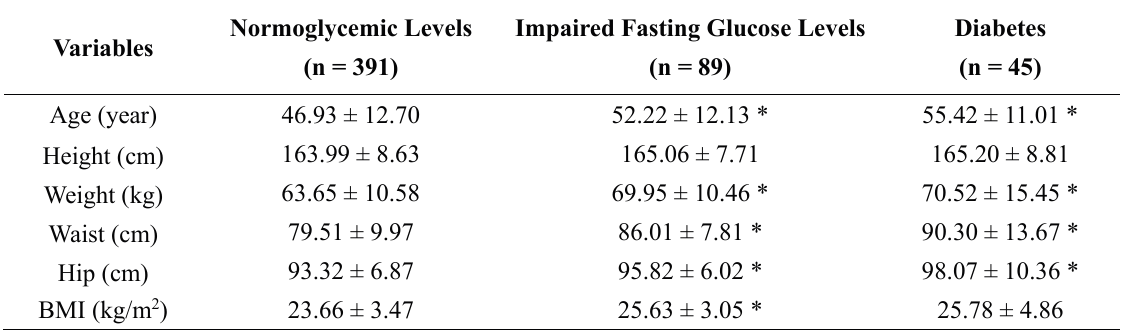
Table 2. Characteristics of subjects with normal/impaired fasting glucose levels or